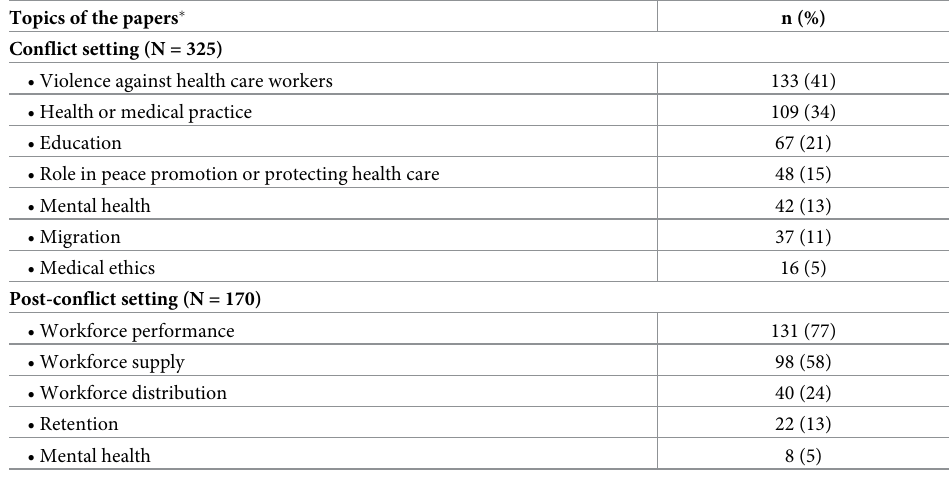
Table 1. Topics focus of the papers on health care workers in conflict (N = 325) and post-conflict (N = 170) settings. Topics of the papers